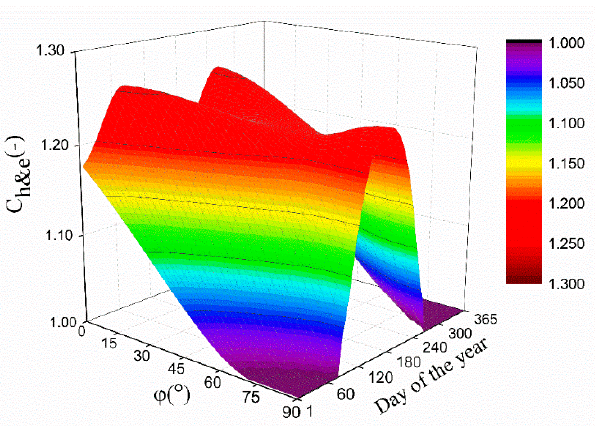
Figure 20. Surface chart of 𝐶 (cid:3035)&(cid:3032) varying with day of the year and different latitudes at 𝛽 = 0 .